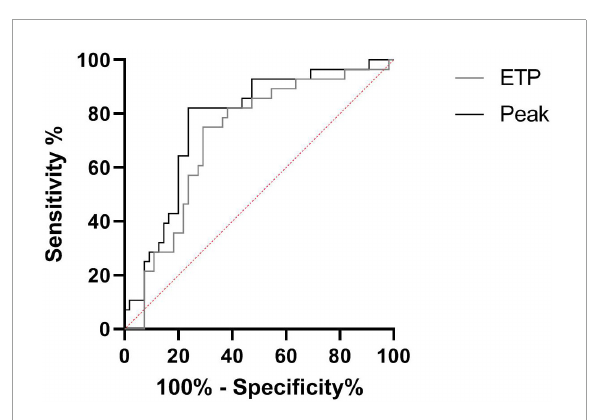
FIGURE3 Receiver operating characteristic (ROC) curve of VOC prediction by TGA. Comparison between SCD in steady state and SCD developing VOC in a year. ETP, endogenous thrombin potential (with an ETP > 1,207 nM.min: AUC: 0.71, sensitivity: 75.1%, specificity: 70.9%; With a Peak > 228.5 nM: AUC: 0.77, sensitivity: 82.1%, specificity: